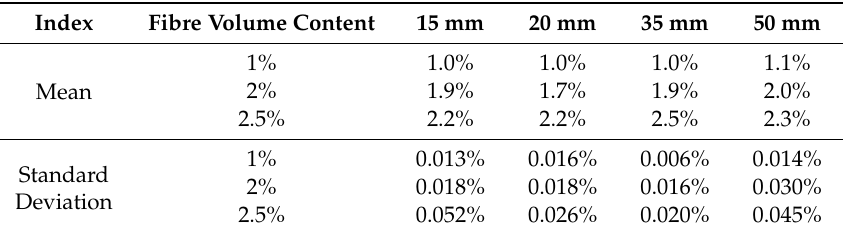
Table 6. Mean and STD of fibre volume content of all plates.